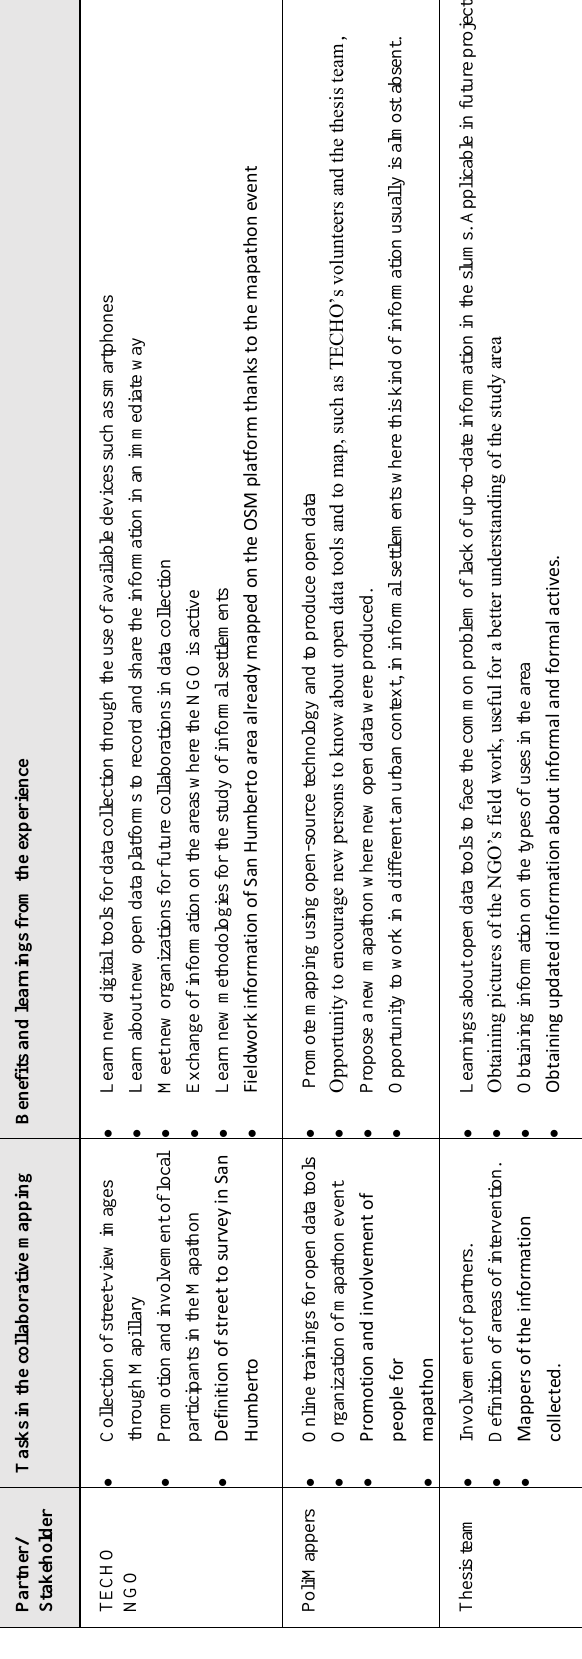
Tab 1. Tasks and common benefits of the